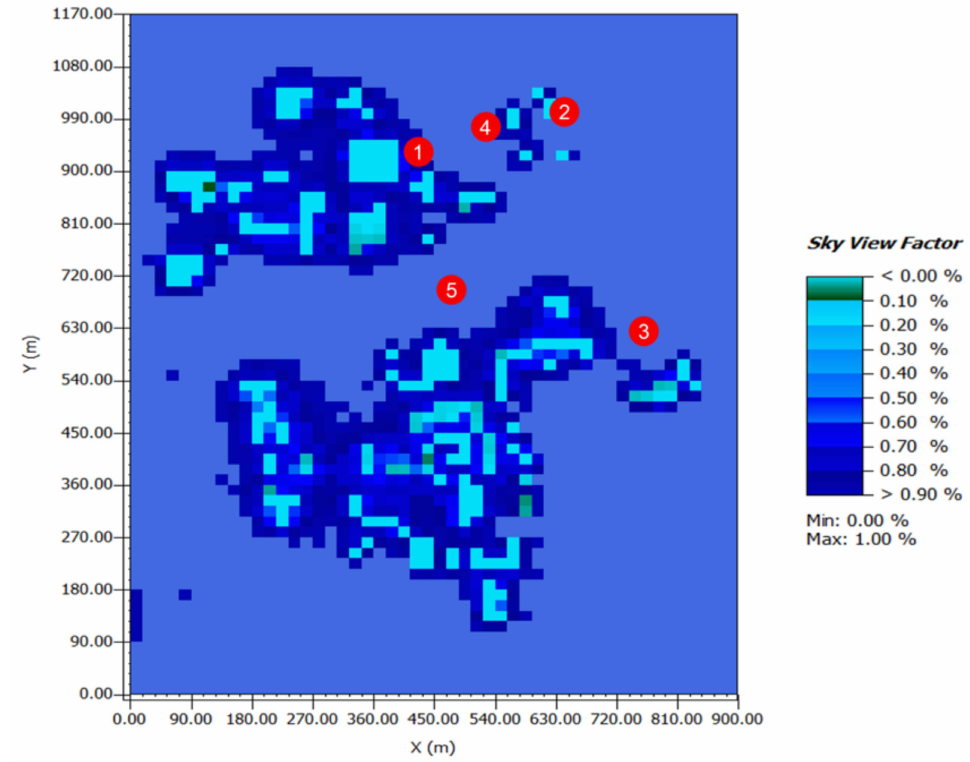
Figure 6. Calculated sky view factors of the site (the numbers represent each location of